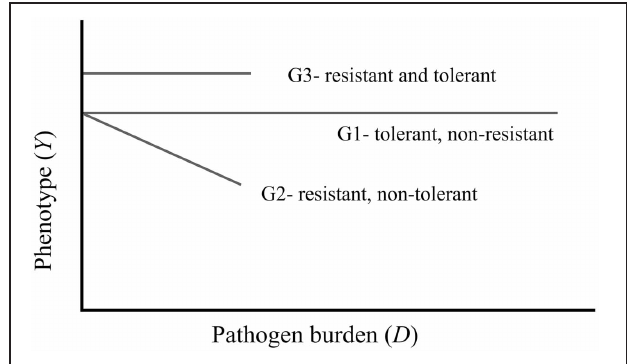
FIGURE 1 | The common portrayal of phenotypic responses of genotypes with a single predictor variable of pathogen burden. The three genotypes represented here are tolerant and not resistant (G1), resistant and not tolerant (G2), and resistant and tolerant